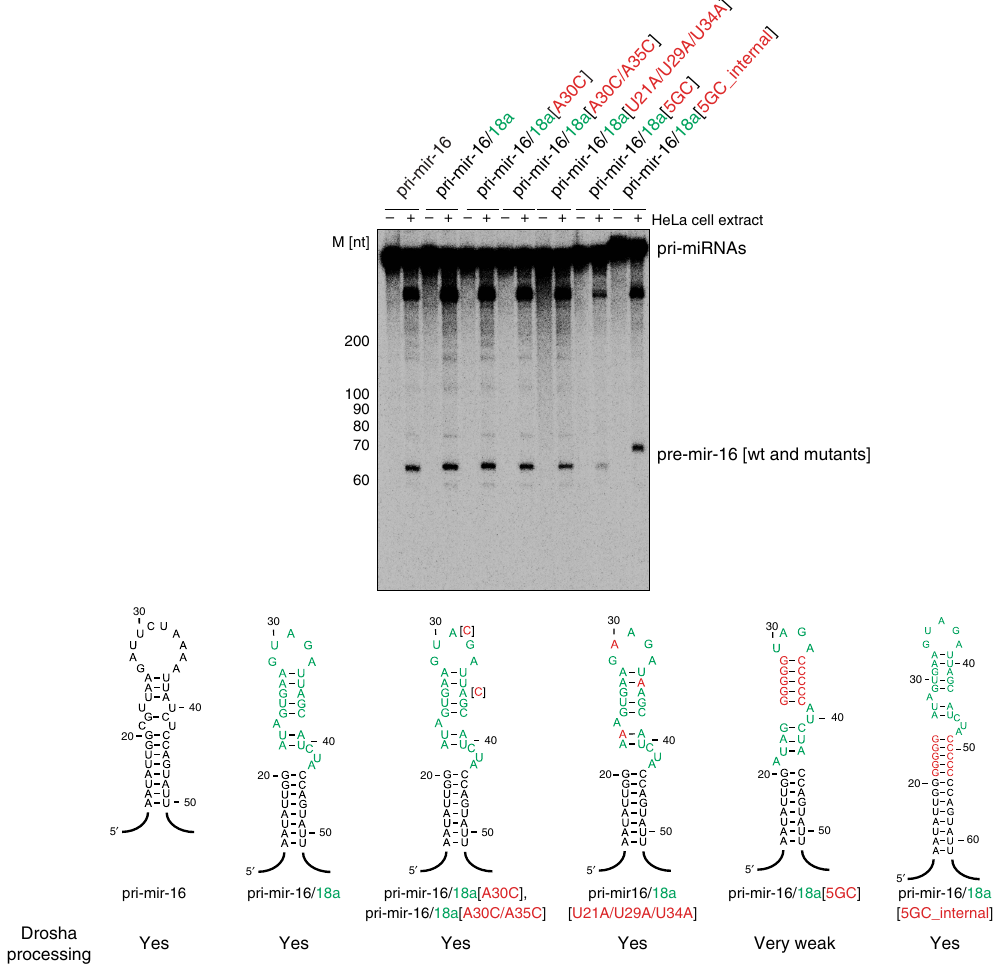
Fig. 7 In vitro processing of pri-mir-16 and 18a chimerae. Wild-type pri-mir-16 or chimerae with 18a terminal loop sequences (in green) with point mutations introduced in Supplementary Fig. 6 (in red) were subjected to in vitro processing assay. All transcripts, except for pri-mir-16/18a[5GC], are ef fi ciently processed by Drosha. Pri-mir-16/18a[5GC] processing ef fi ciency is reduced, indicating that conformational changes to the pri-mir stem